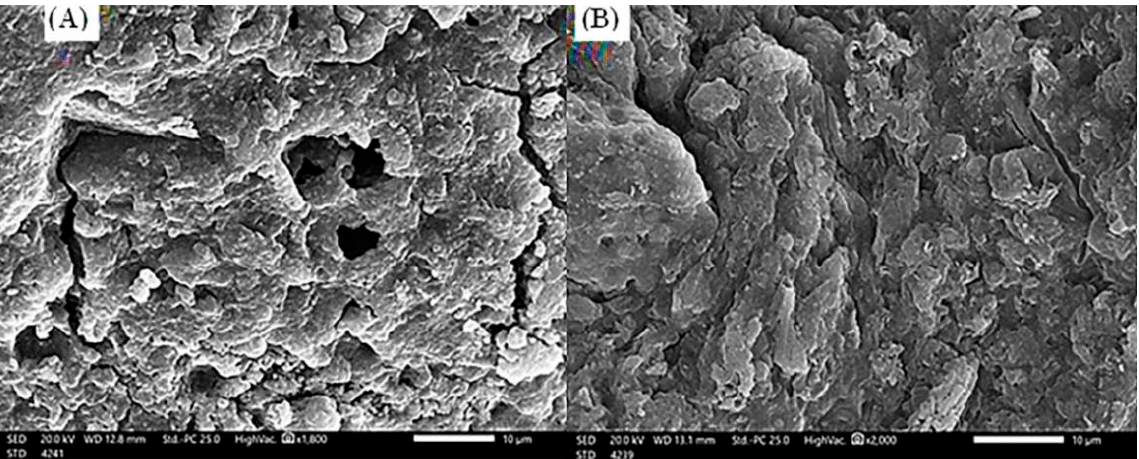
Figure 2. Scanning electron microscope (20.0 kv, ×2000) of S. costatum adsorbent before ( A ) and after ( B ) adsorption of CVD.